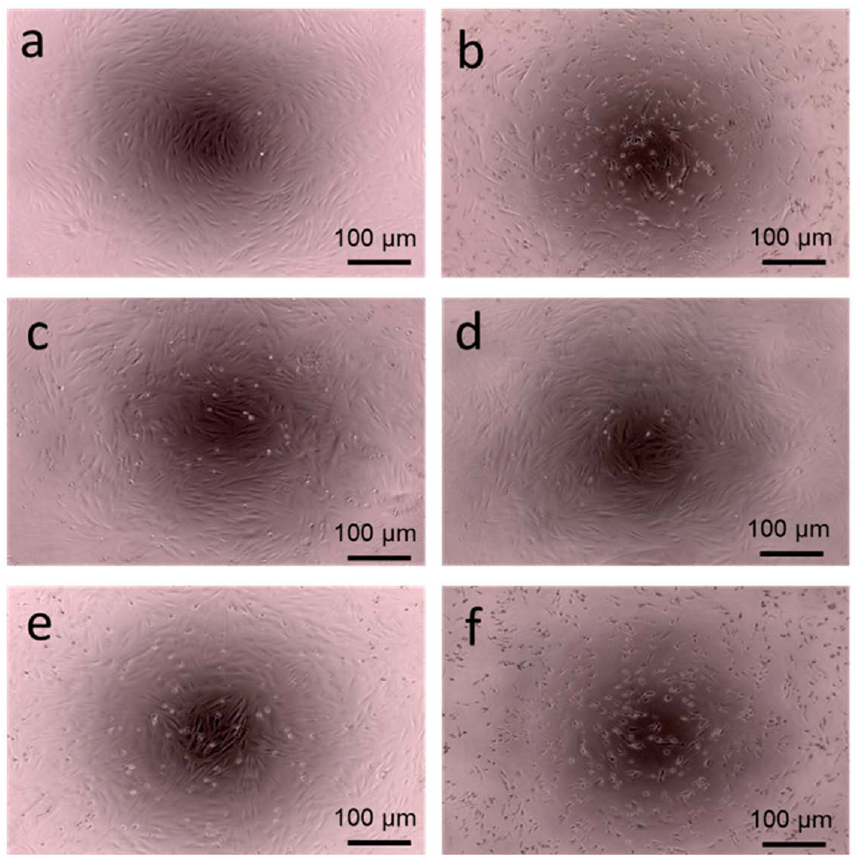
Figure 5. Cytotoxic effects of ( b ) PAMAM-3-CA, ( c ) PAMAM-3-FA, ( d ) PAMAM-3 PhA, ( e ) PPI-3-FA and ( f ) PPI -3-PhA at 100 µ mol/L on a human dermal fibroblast cell, compared with ( a ) a blank living cell. Cells were imaged using an EVOS XL Core inverted microscope ( × 10